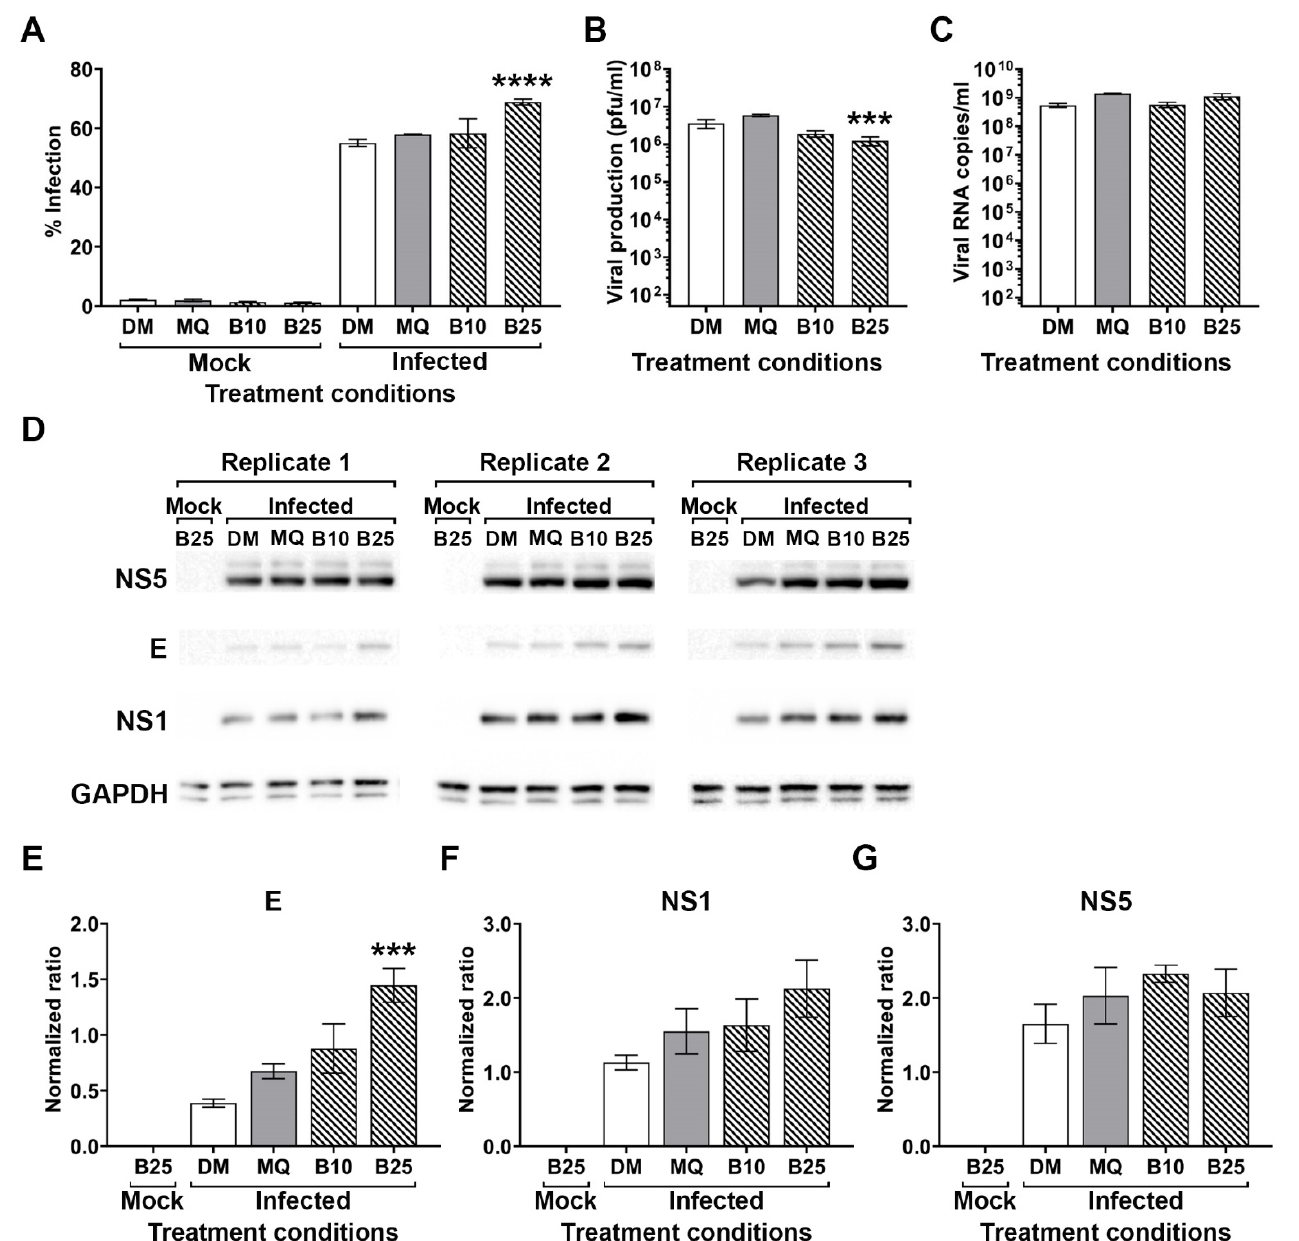
Figure 3. Effect of BBR on DENV infection. BHK-21 cells were mock or DENV 2 infected before being treated with an equivalent volume of DMEM, MQ water or 10 or 25 µM of BBR for 24 h. After 24 h cells and supernatants were collected. ( A ) Level of infection was determined by flow cytometry. ( B ) DENV 2 titer in the supernatant was determined by plaque assay. ( C ) Level of genome in cells was determined by quantitative real-time RT-PCR. ( D ) Levels of DENV NS5, E and NS1 proteins were determined by western blot in parallel with host cell GAPDH as a control. ( E – G ) Band intensities from ( D ) were quantitated and normalized to expression of GAPDH. All experiments were undertaken independently in triplicate, with duplicate plaque assay. Error bars show ± S.E.M. *** p ≤ 0.001, **** p ≤ 0.0001).